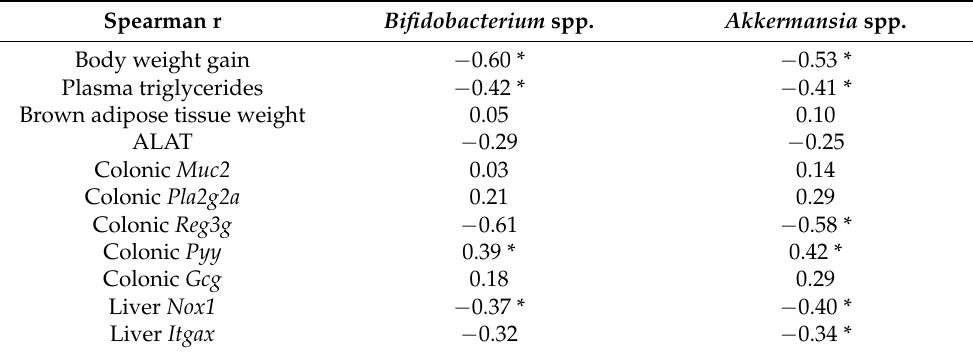
Table 3. Correlation analysis between increased cecal bacteria and host parameters significantly modulated by berberin or curcumin treatments 1